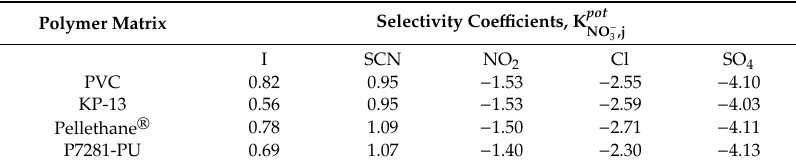
Figure 2. Calibration curves of NO 3 -ISFETs. ( a ) Only KNO 3 solution. ( b ) In artificial saliva. Table 1. Selectivity coe ffi